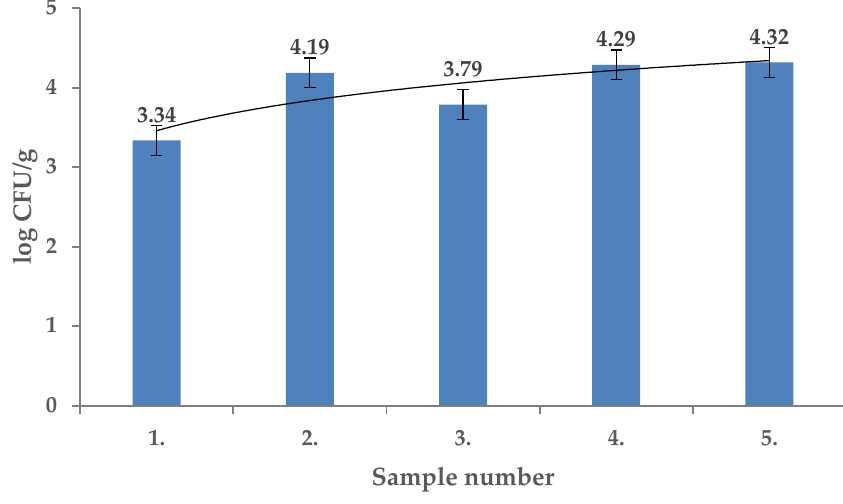
Figure 1. Total viable counts (TVC) in fruits of Rosa canina.